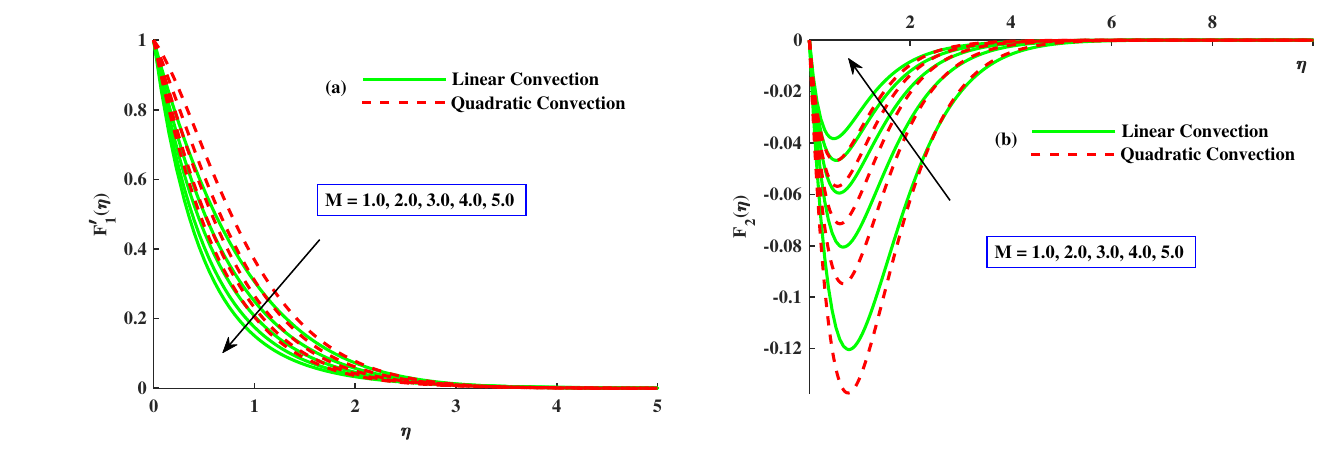
Figure 3. The influence of M on the F 1 (cid:48) ( η ) and F 2 ( η ) .